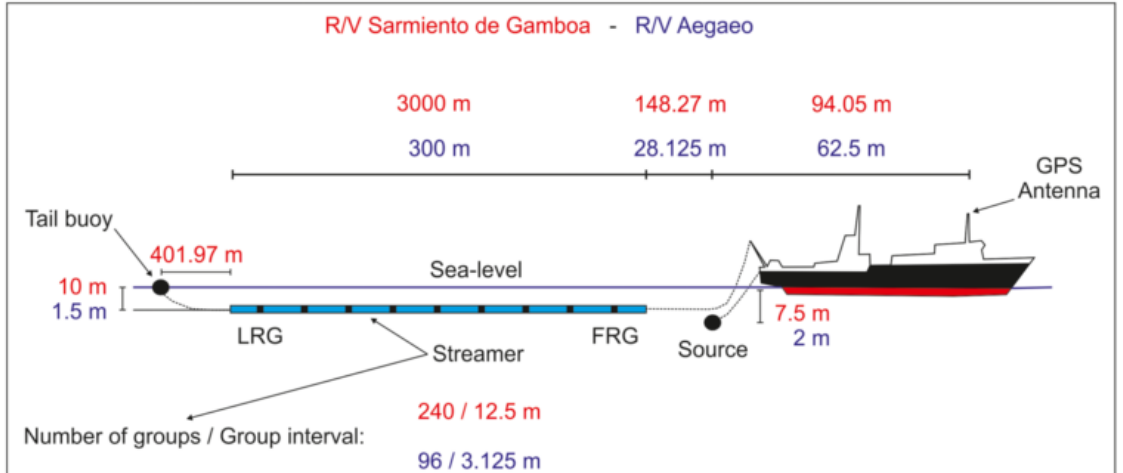
Figure 1. MCS acquisition geometries adopted for the two TOMO-ETNA cruises (red: R/V “Sarmiento de Gamboa”; blue: R/V “Aegaeo”). FRG - First Receiver Group; LRG - Last Receiver